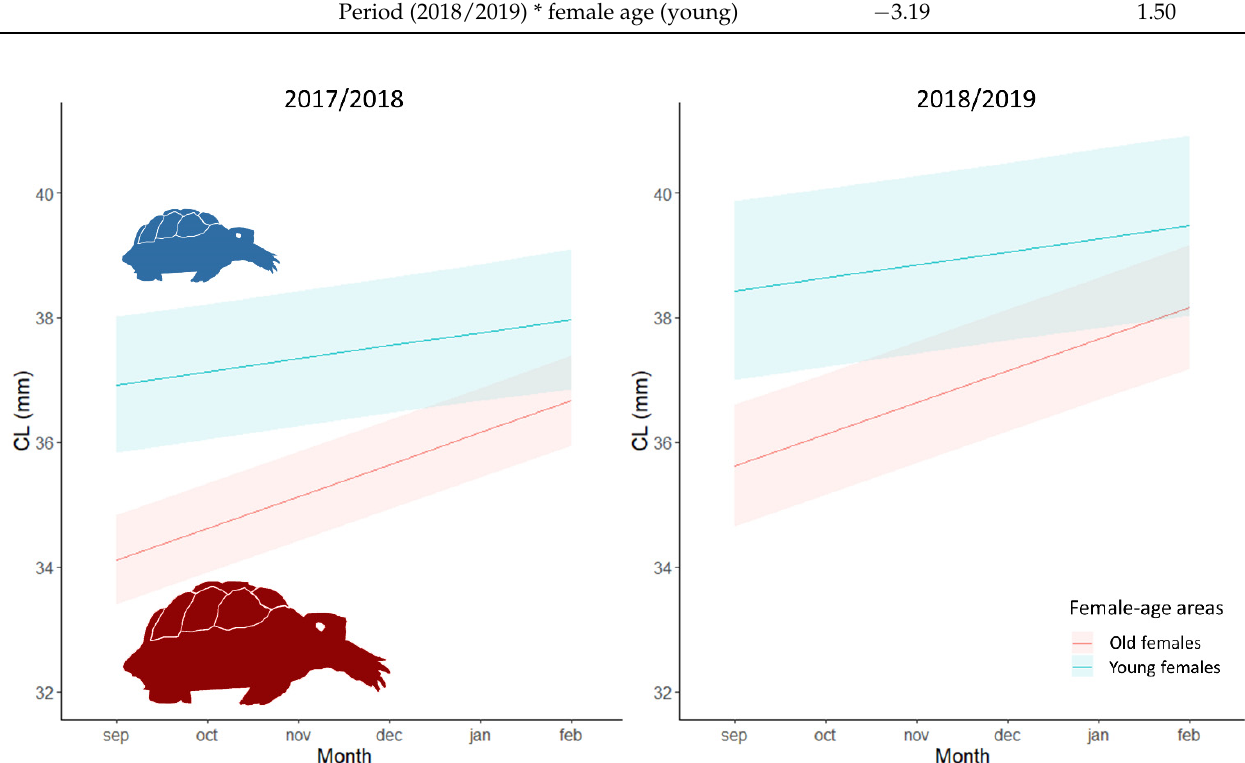
Figure 2. Relationship between body size (carapace length, CL, in mm) and months for hatchlings from young females (in blue) and old females (in red) during the study period. Body size was calculated with the linear mixed model that best fit the observed data, which include the interaction of month and female age, the additive effect of period and the random effect of the individual (Table 2). Lines represent the estimated mean values, and the shadow areas correspond to the confidence interval (95%).